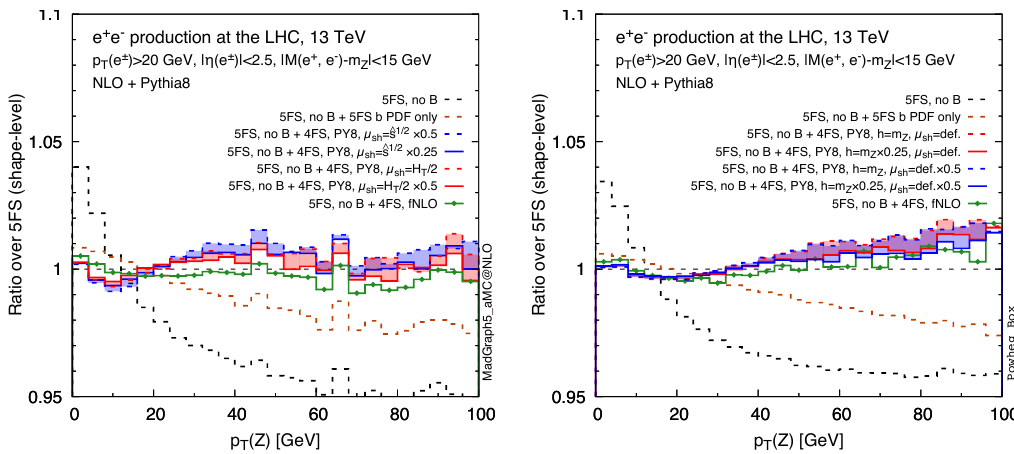
Figure 10 . Ratio of the p ‘ + ‘ (cid:0) distribution in the re(cid:12)ned approximation including bottom-quark ? mass e(cid:11)ects over the plain